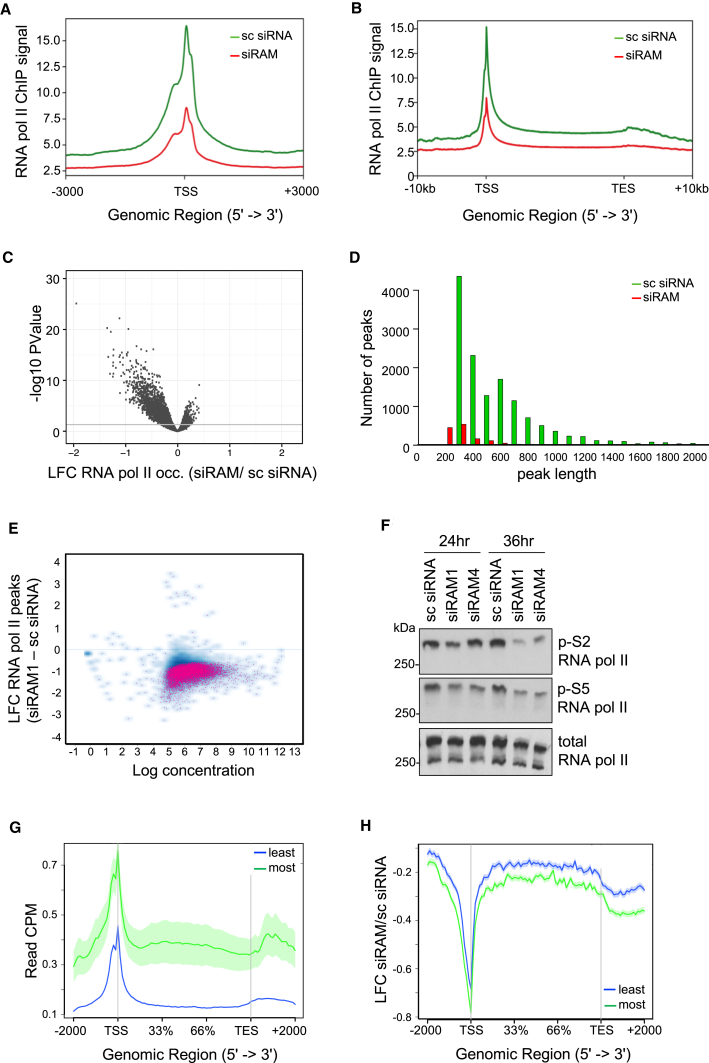
RNMT-RAM Regulates RNA Pol II Occupancy(A and B) RNA Pol II ChIP-seq reads over annotated transcription start sites (A) and annotated genes (B) within the hg38 human assembly, 36 hr post-transfection with siRAM (red line) or sc siRNA (green line). Signal was normalized to inputs.(C) Volcano plot of log2 fold change in RNA Pol II ChIP-seq reads uniquely aligned to gene locus ± 2 kb following RAM siRNA transfection and log10 p value. Horizontal line, p value of 0.05.(D) Number of RNA Pol II ChIP peaks called using MACS2 plotted against peak length for sc siRNA- and siRAM-transfected cells.(E) Scatterplot of log2 fold change of RNA Pol II peaks following RAM depletion. False discovery rate (FDR) < 0.05 is highlighted.(F) HeLa cells transfected with two RAM siRNAs or sc siRNA for 24 and 36 hr. Western blot analysis is shown.(G) RNA Pol II ChIP-seq reads from control siRNA-transfected cells. Genes for transcripts were categorized as most reduced and least reduced in RNA-seq following RAM depletion (Figure S2E).(H) Log fold change in RNA Pol II ChIP-seq reads following RAM knockdown over gene sets plotted in (G).Data were pooled from three biological replicates for (A)–(E). TSS, transcription start site; TES, transcription end site.